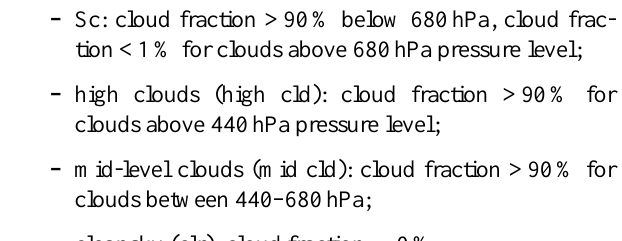
is performed on the pixel scale within these boxes, with no averaging among the